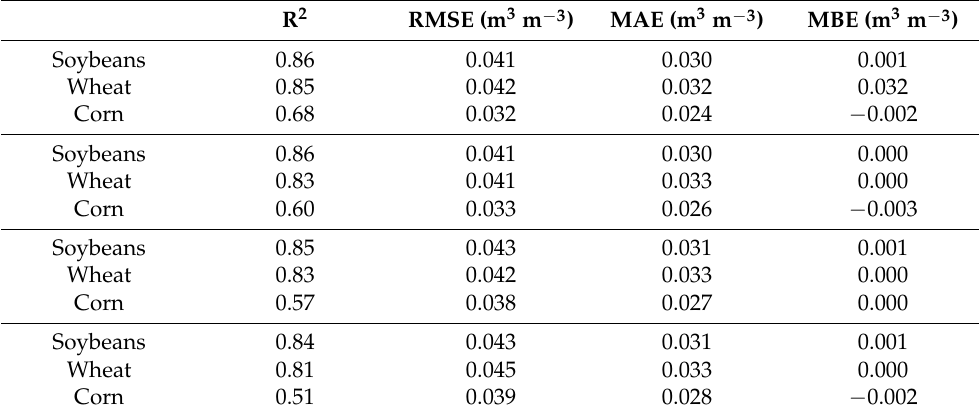
Table 7. Soil moisture retrieval accuracies using selected features from Table 6 and a random forest